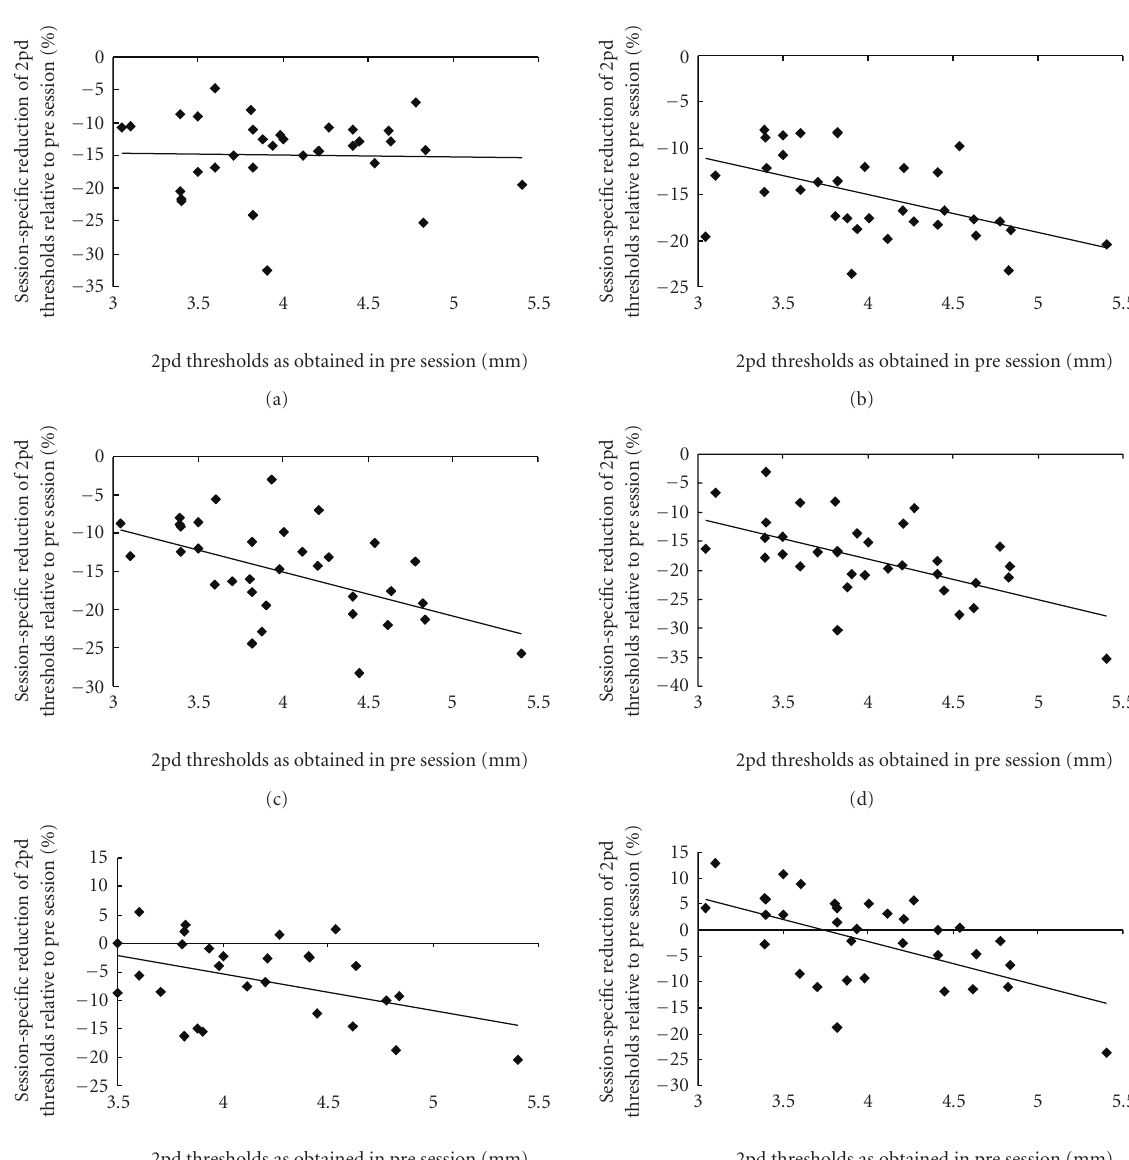
Figure 2: Gain in tactile acuity as a function of baseline performance. Plotted are percent changes (respective post session compared to pre session) in two-point discrimination (2pd) thresholds. (a) Although two-point discrimination thresholds of all fingers were reduced after the first application of rES (post), no correlation between initial threshold level and gain in performance was found (Pearson-correlation, r = − 0 . 026, P = . 884). In contrast, during succeeding sessions, a significant correlation emerged, which was maintained up to 2 weeks after termination of rES ((b) post-w2 ( r = − 0 . 499, P = . 002); (c) post-w3 ( r = − 0 . 508, P = . 002); (d) post-w4 ( r = − 0 . 545, P = . 001); (e) rec-w1 ( r = − 0 . 461, P = . 005); (f) rec-w2 ( r = − 0 . 530, P = . 001)).